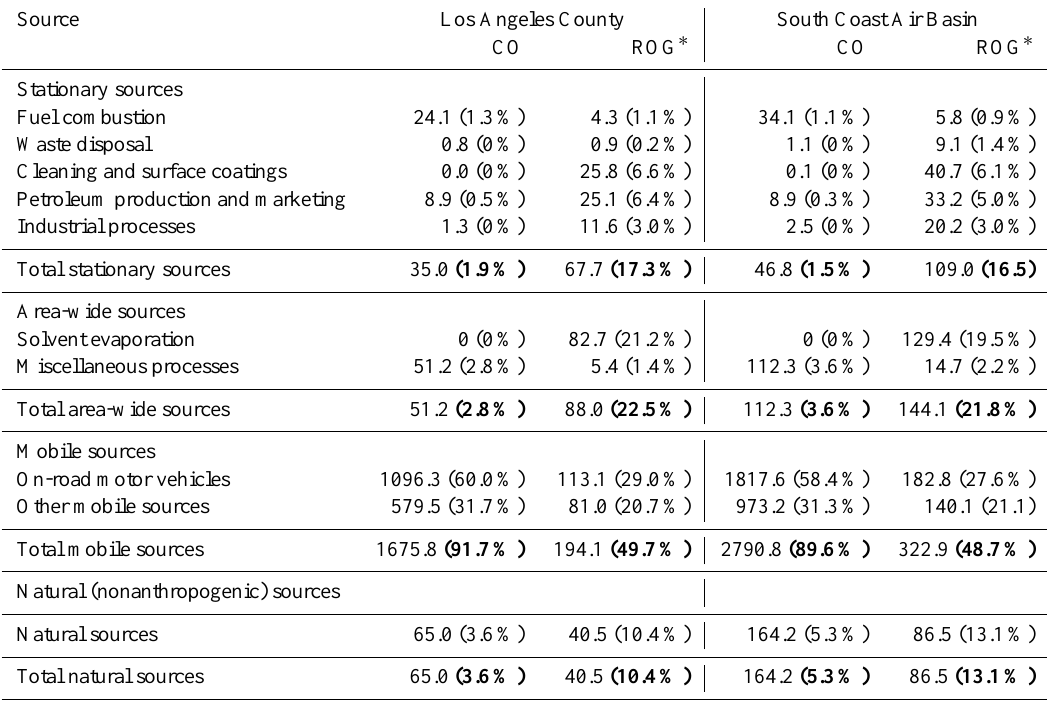
Table 5. CARB 2010 estimated daily emission rates (annual average). Units are in metric-tons per